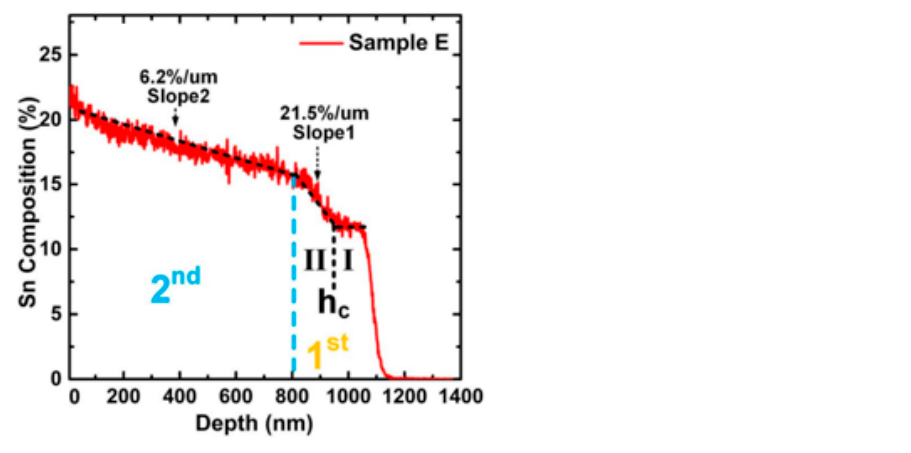
Figure 14. SIMS result for the GeSn sample with an Sn content of up to 22.3% (the maximum Sn contents for regions I, II, and III were 11.9%, 15.5%, and 22.3%, respectively). Reproduced from [113], Springer Nature, open access, 2018.